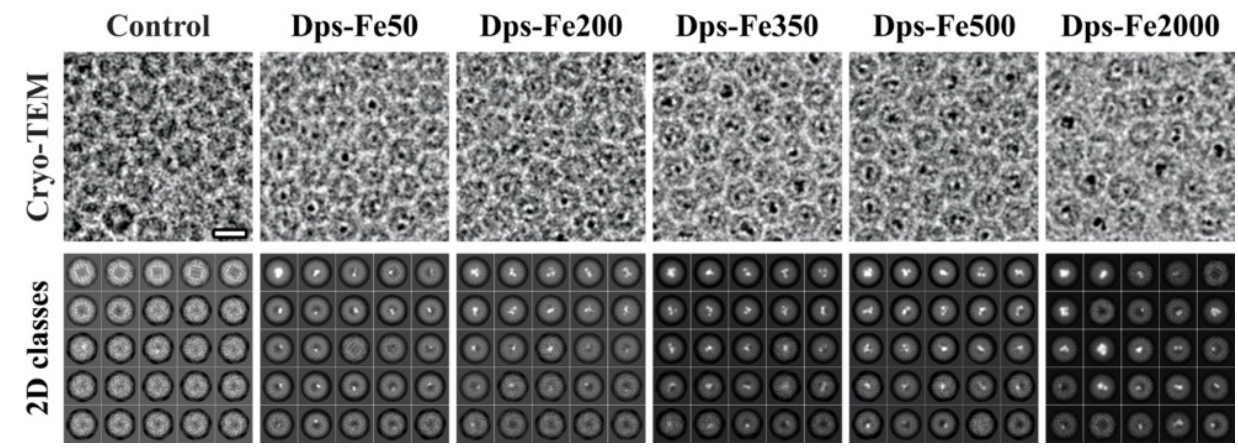
Figure 1. Typical cryo-EM images (1st line) and 2D class averages (2nd line) of Dps dodecamers with an estimated iron loading of 50–2000 atoms (left to the right) after 24 h incubation showing different morphologies of the iron clusters. Bar for cryo-EM images is 10 nm, each of 2D class averages is 12.5 nm wide.